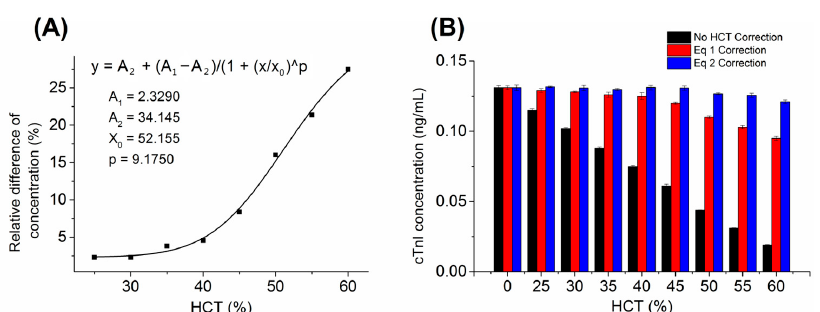
Figure 2. ( A ) Standard curve of relative difference of the concentration of cTnI vs. HCT value. ( B ) HCT effect for cTnI CLIA detection.